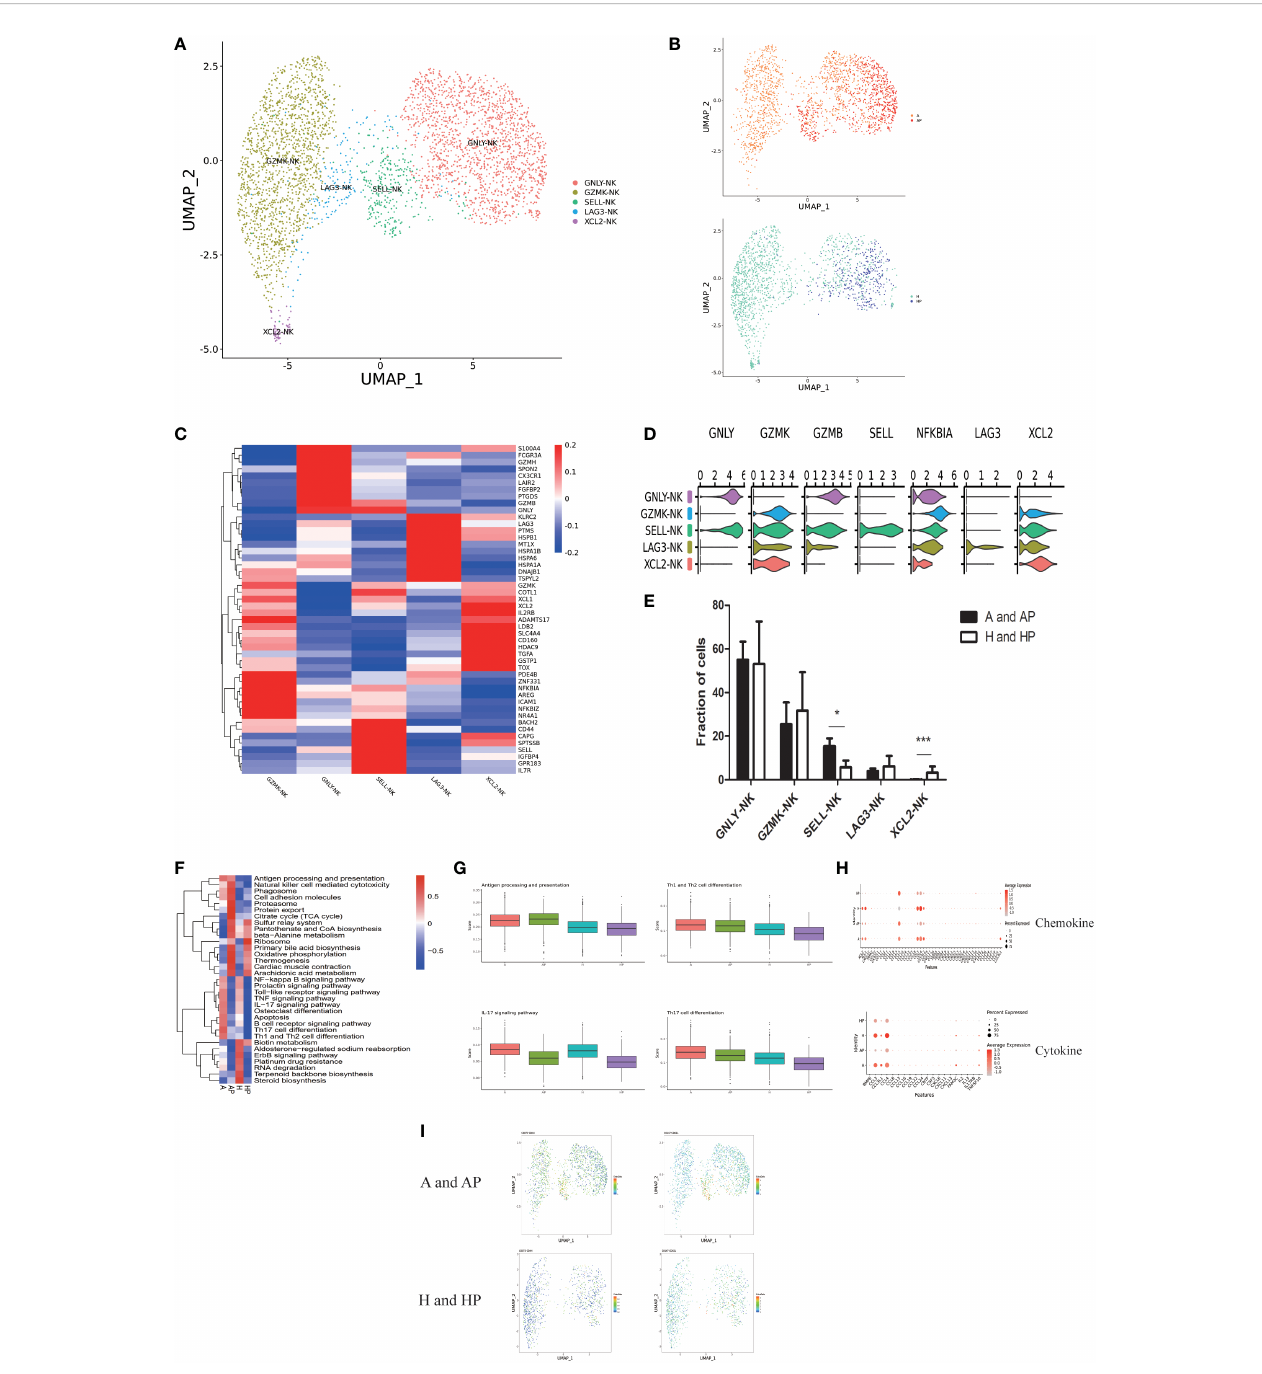
FIGURE 5 Identifying NK cell subpopulations. (A) Clustering of 3578 natural killer (NK) cells from fi ve liver tissue and peripheral blood samples (n = 2 healthy and n = 3 alcoholic cirrhosis). (B) Annotation of NK cells by patient ’ s condition. (C) Heatmap of NK cell cluster marker genes. (D) Scaled gene expression in NK cells. (E) Fraction of NK cells. (F) QuSAGE analysis of NK cells in the A, AP, H, and HP groups. (G) Single-sample GSEA (ssGSEA) analysis of NK cells in the A, AP, H, and HP groups. (H) Cytokine and chemokine analyses of NK cells in the A, AP, H, and HP groups. (I) Proteomic analysis of CD62L and